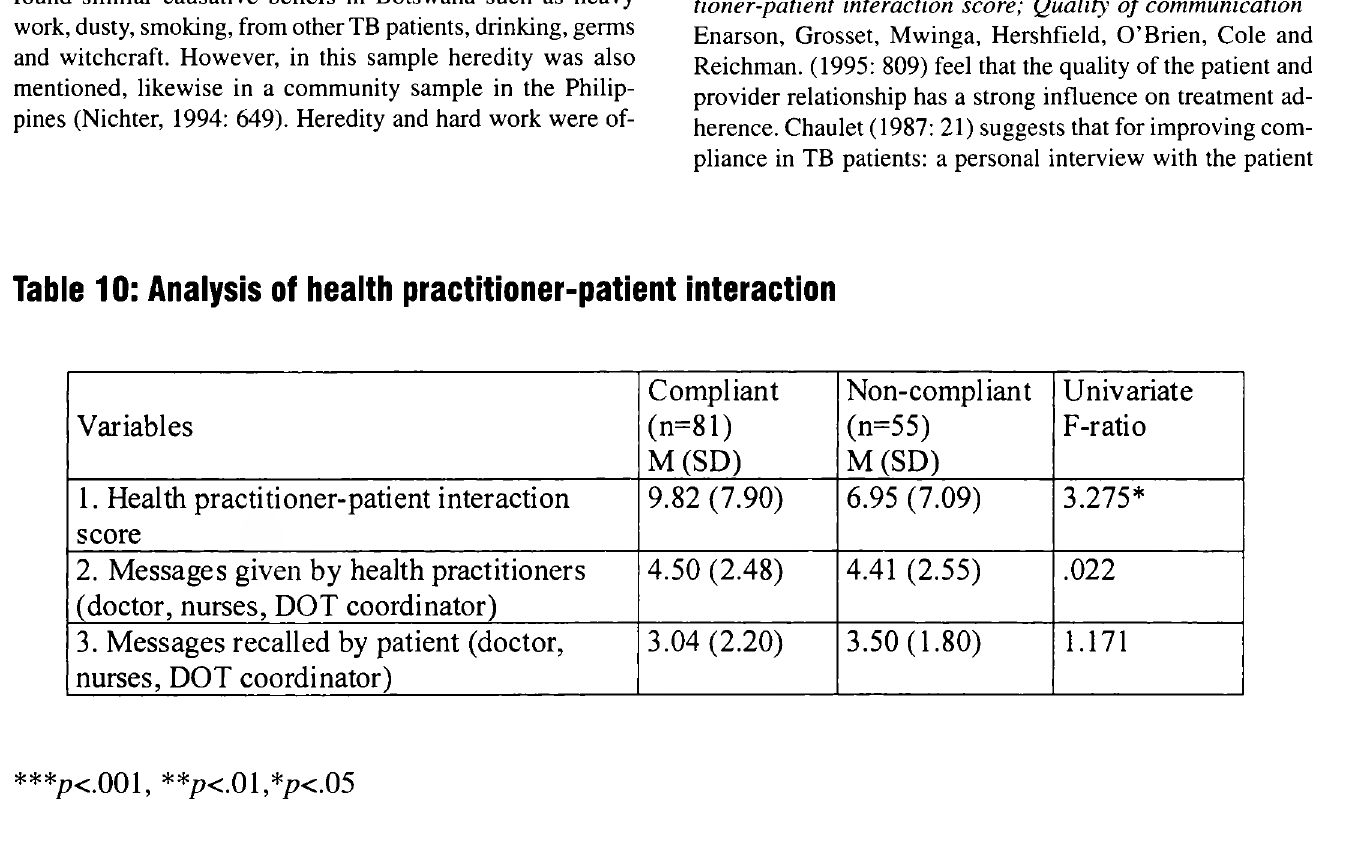
Table 10 : Analysis of health practitioner-patient interaction